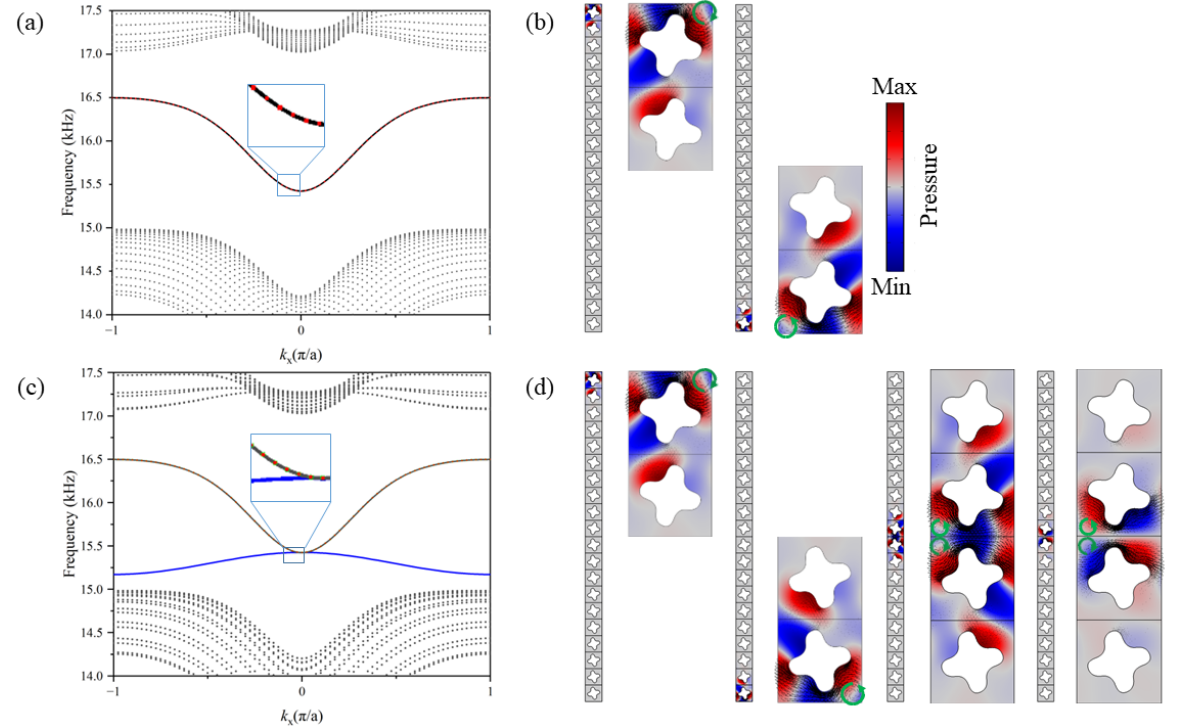
Figure 3. ( a ) The energy band of a supercell consisting of 20 × 1-unit cells with the same structure (crystal A). ( b ) The eigenmodes (acoustic pressure field) localized at the top boundary with clockwise vortex and at the bottom with counterclockwise vortex. ( c ) The energy band of a supercell consisting of 20 × 1-unit cells with different structures (crystal A and crystal B). ( d ) The acoustic pressure field shows the edge states localized at the top boundary and the bottom boundary, as well as the interface states between the two different crystal structures. In ( a , c ), the red dotted line and the black solid line represent the edge states localized at the top boundary and the bottom boundary, respectively; the green hollow circle and the blue solid line indicate the two interface states induced by the valley-like insulators; the gray dotted lines represent the bulk bands. In ( b , d ), the arrows in the acoustic eigenmode fields represent the Poynting vectors; the additional green arrows indicate the location of vortex cores.